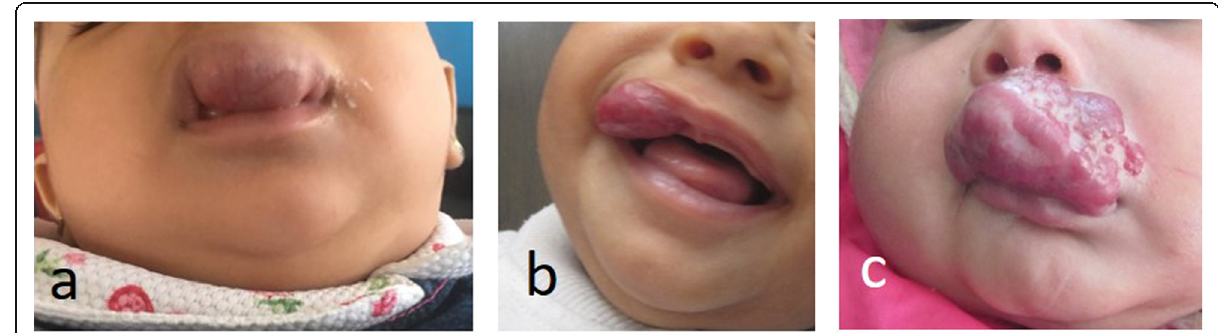
Fig. 1 Infantile haemangioma of the upper lip in three different cases showing the characteristic appearance of red, compressible papules